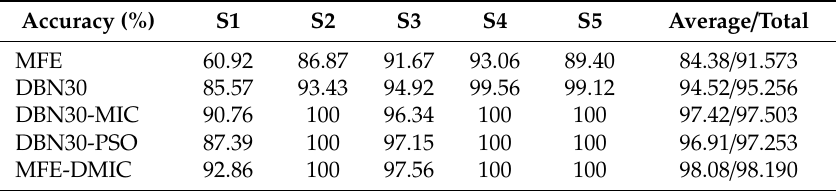
Table 5. SVM classification accuracy using di ff erent feature extraction and optimization Table 8. SVM classification accuracy using different feature extraction and optimization algorithms